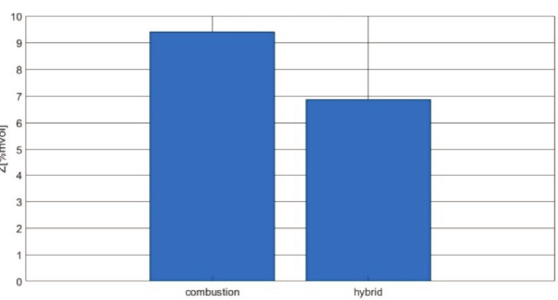
Fig. 17. The total emission for propulsion